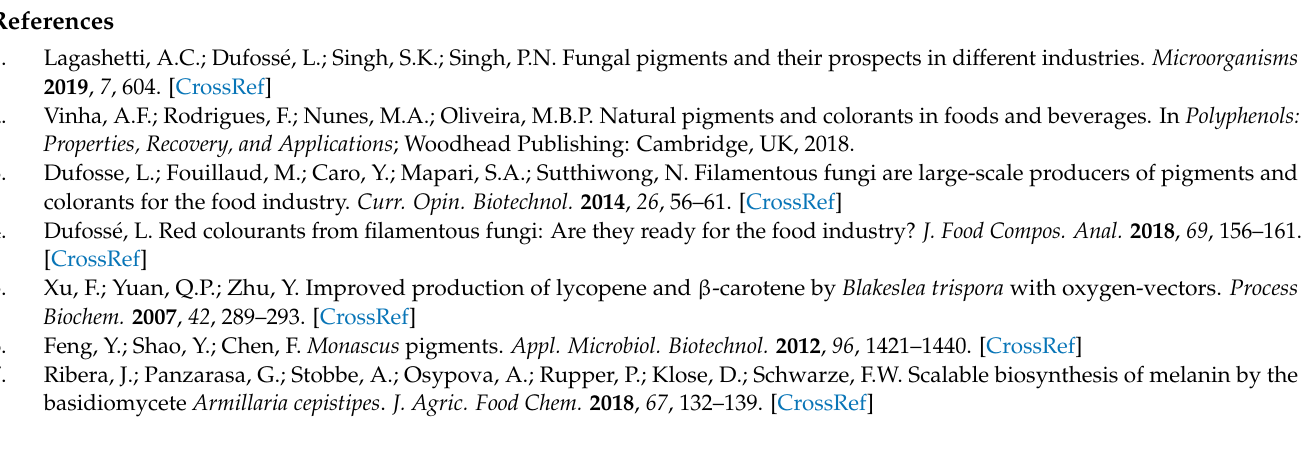
software. Table S2: Comparisons of genome features between A. resinae KUC3009 and its close resinae genome. Table S4: Putative multi-copper oxidase genes found in the A. resinae